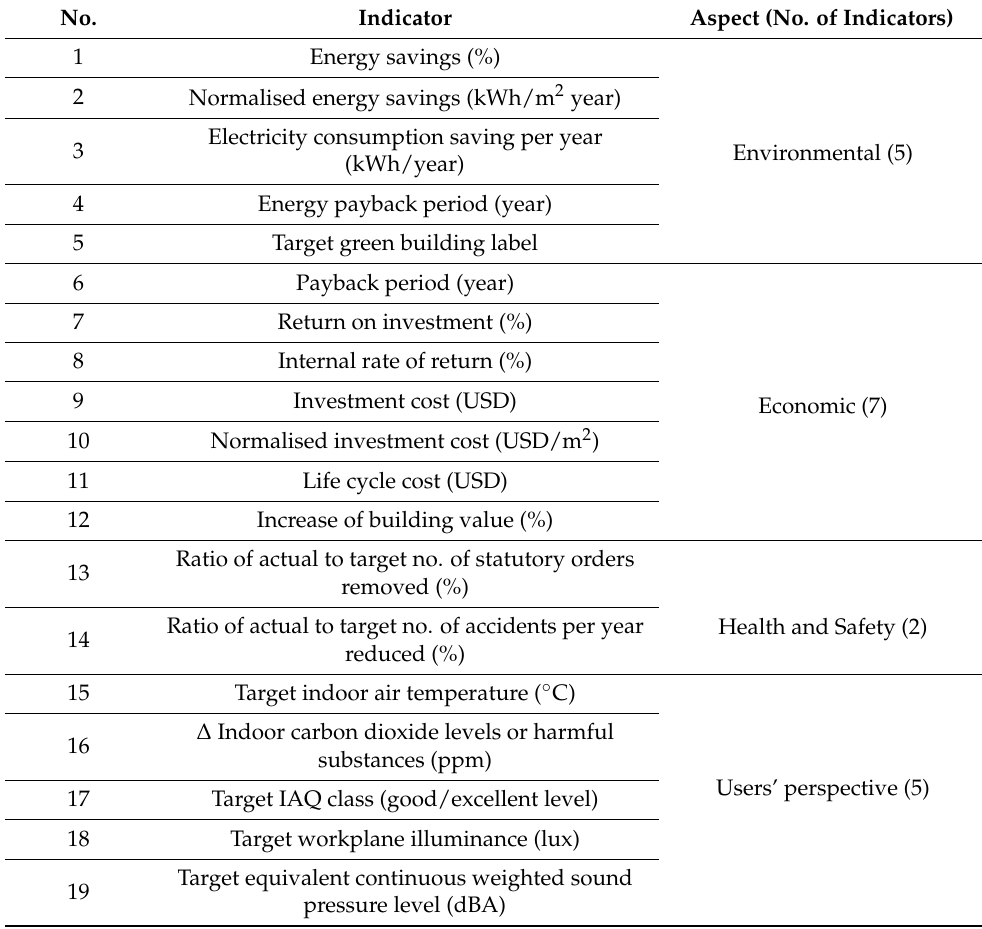
Table 1. Performance indicators selected from the preliminary stages of the study. No. Indicator Aspect (No. of Indicators) 1 Energy savings (%)